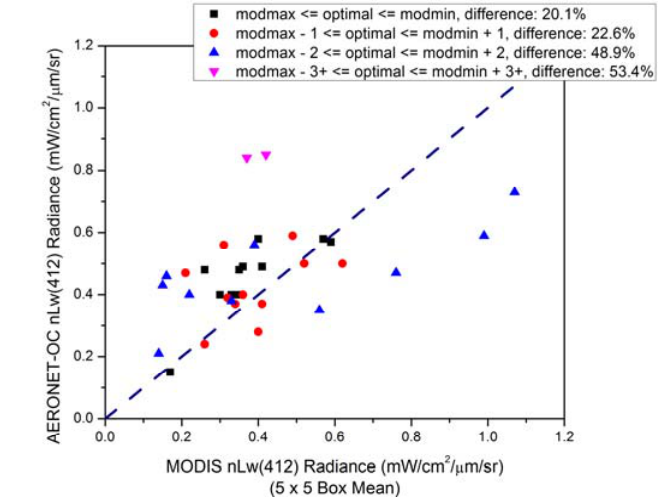
Figure 8. Size fraction sensitivity analysis for automatic aerosol selection (size